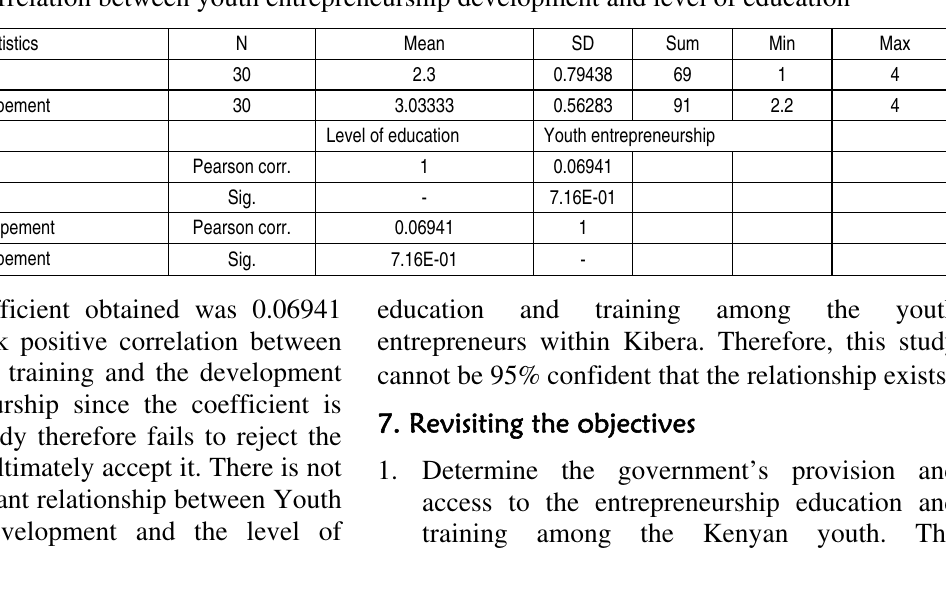
Table 3. Correlation between youth entrepreneurship development and level of